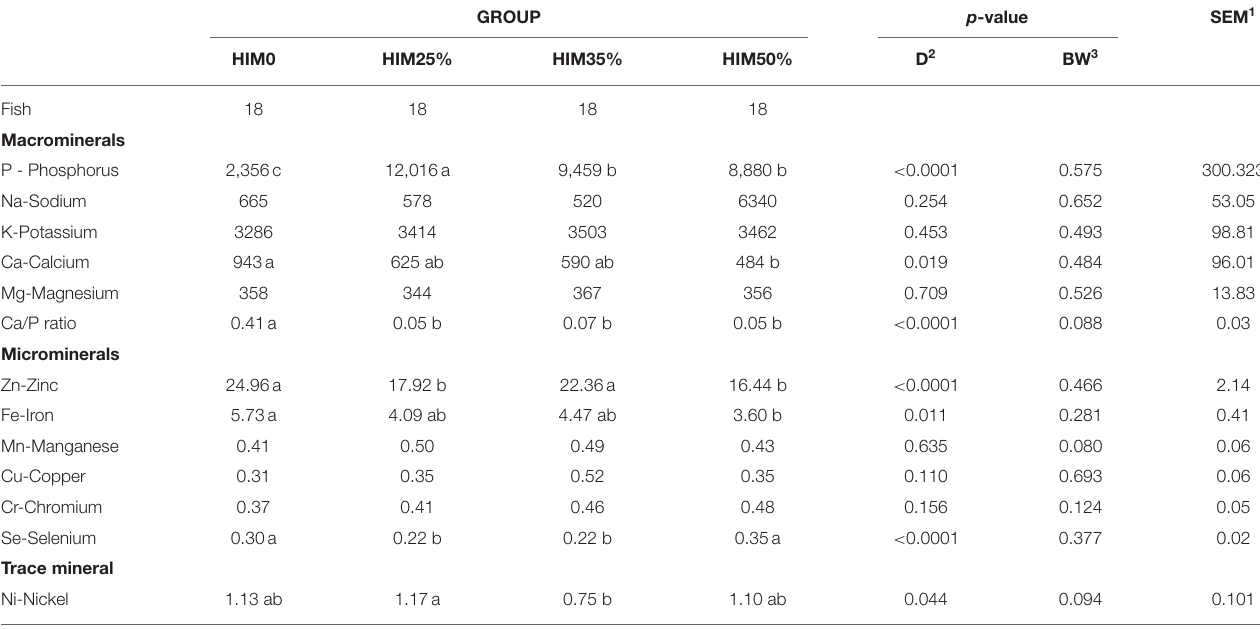
TABLE 8 | Mineral element profile (mg/kg of wet weight) of the filets of the gilthead sea bream fed with the four exerimental diets. GROUP p -value SEM 1 HIM0 HIM25% HIM35%